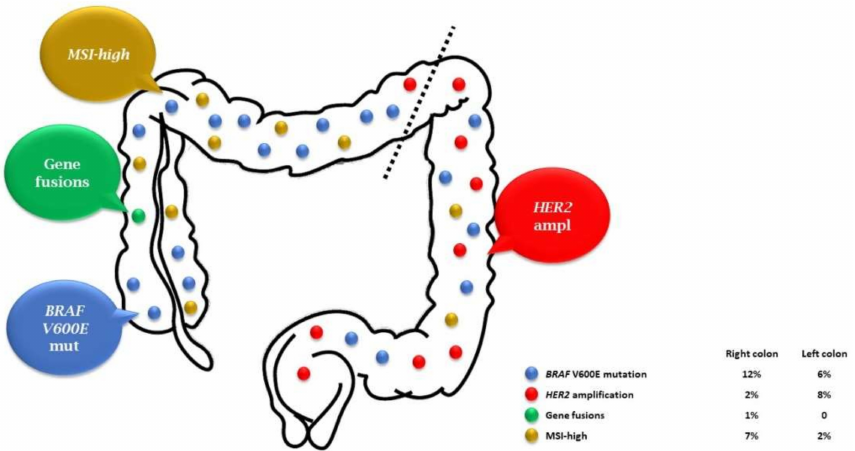
Figure 1. Distribution of molecular alterations in RAS wild-type mCRC, according to primary tumor location (the separation between right- and left-sided colon is indicated by the dotted